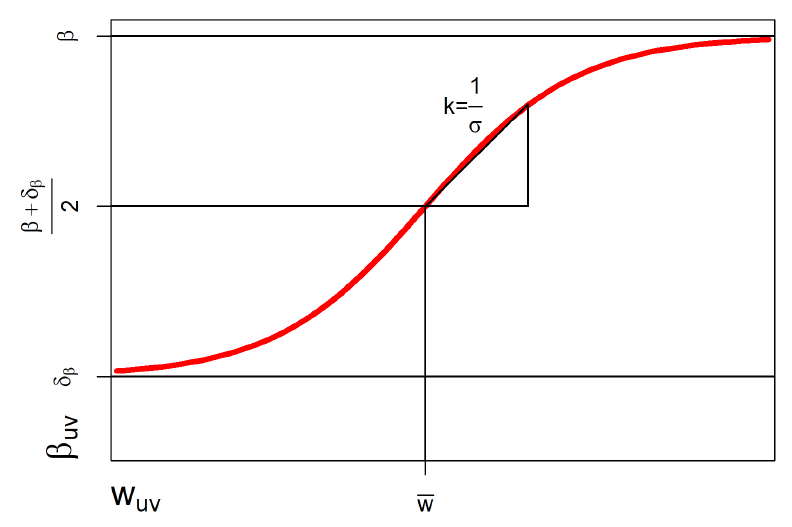
Figure 5. Transformation function for β uv in the range [ δ β , β ] using communication weight w uv